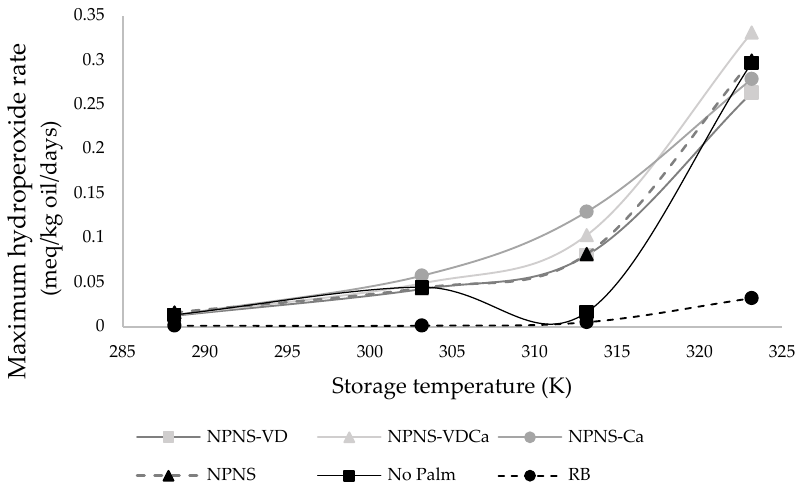
Figure 4. Maximum rate hydroperoxides production plotted as a function of the storage temperature. RB, reference brand; NPNS, spreadable chocolate without palm oil and sugar; NPNS-VD, spreadable chocolate without palm oil and sugar fortified with vitamin D; NPNS-VDCa, spreadable chocolate without palm oil and sugar fortified with vitamin D and Mg-CaCO3 nanoparticles; NPNS-Ca, spreadable chocolate without palm oil and sugar fortified with Mg-CaCO3 nanoparticles.